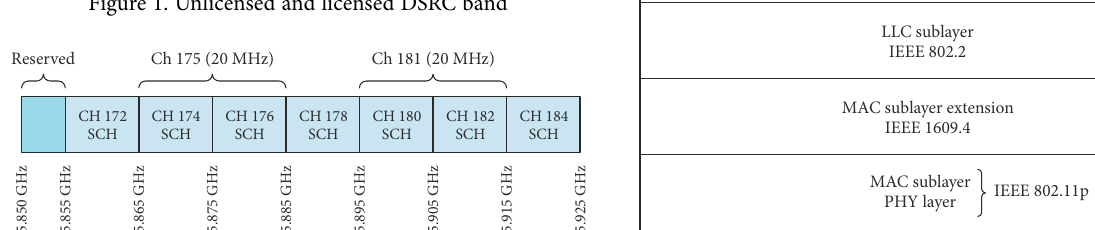
Figure 1. Unlicensed and licensed DSRC band